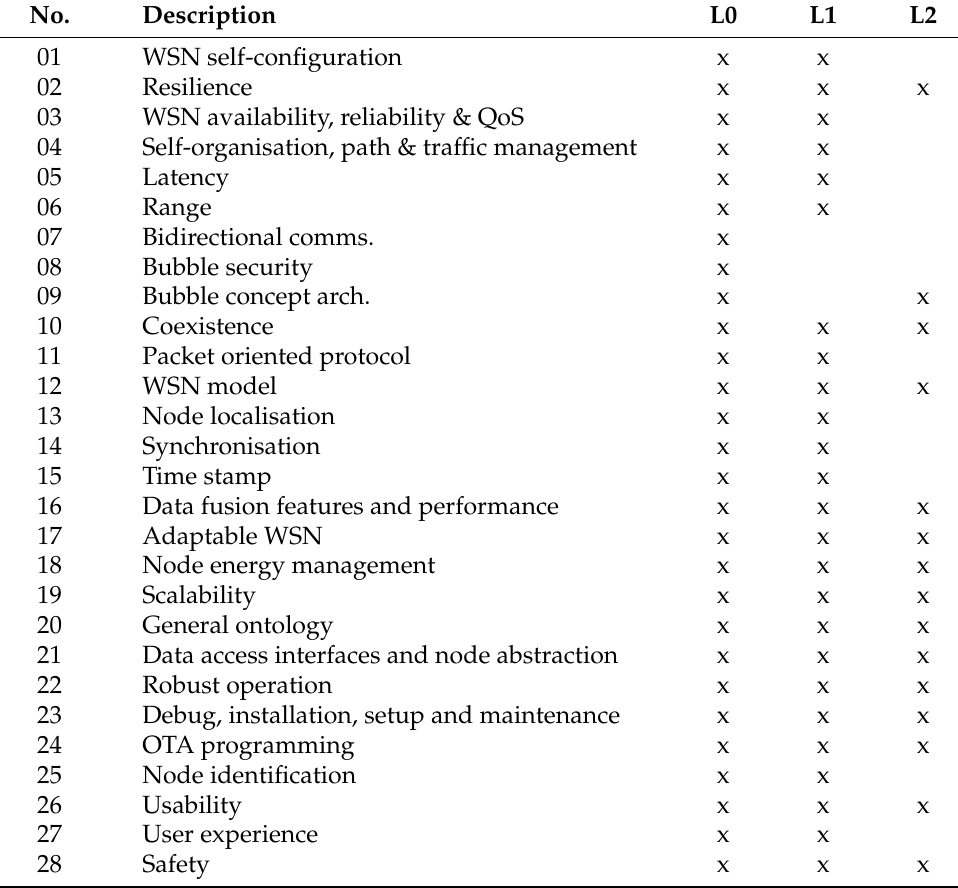
Table 11. Mapping high level requirements (HLRQs) to the DEWI HLA.